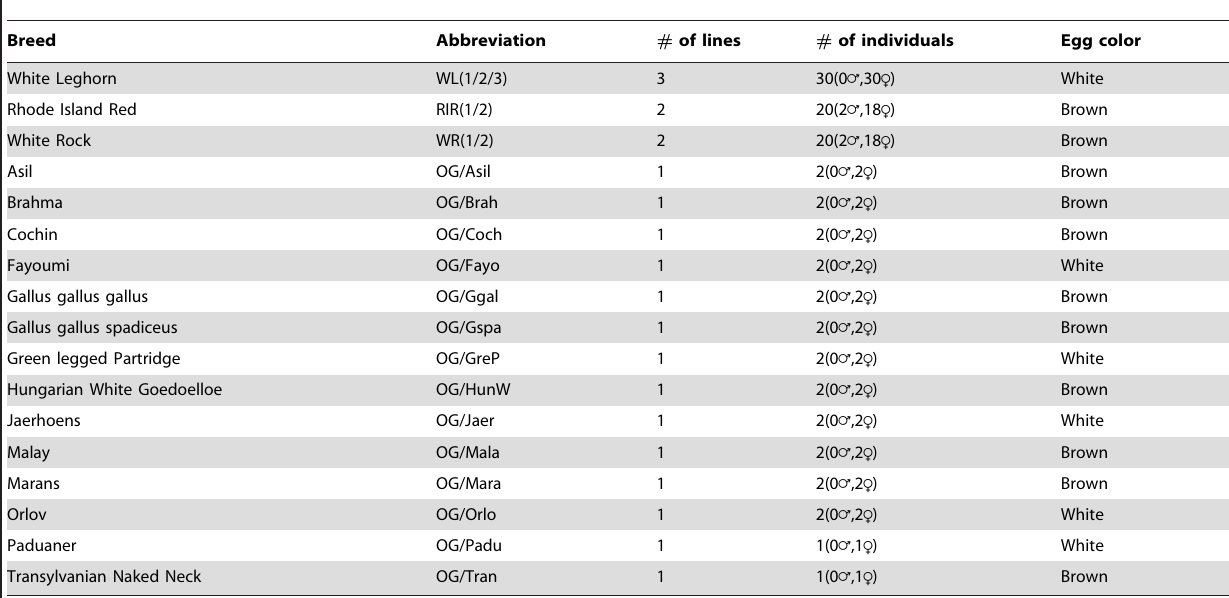
Table 1. Name, abbreviation, number of individuals and the egg color for each breed used in this study.